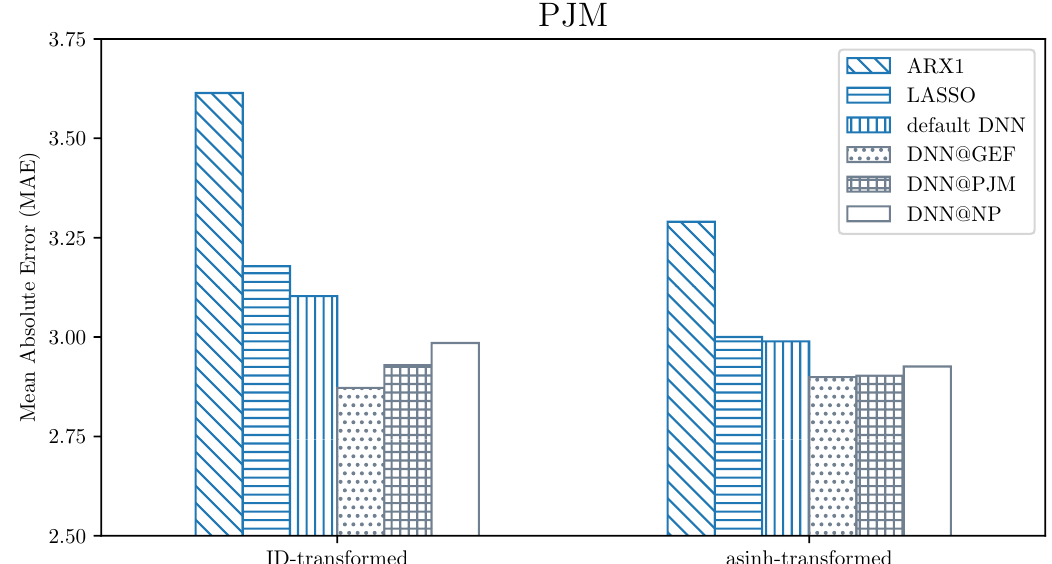
asinh-transformed2 . ID-transformed Figure 3. Visualization of the MAE errors for PJM data across the benchmark (darker shade) and fine-tuned (lighter shade) ensembles, separately for identity (ID) (left part) and asinh-transformed data (right part). Each bar represents the ensemble of all forecasts made using a given model (represented by a filling pattern). The @DATA notation refers to the precalibration dataset used for hyper-parameter selection.